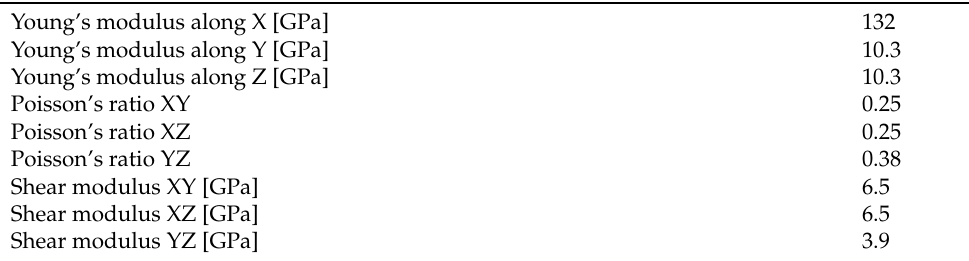
Table 2. Elastic properties of T700S/2592 [34].